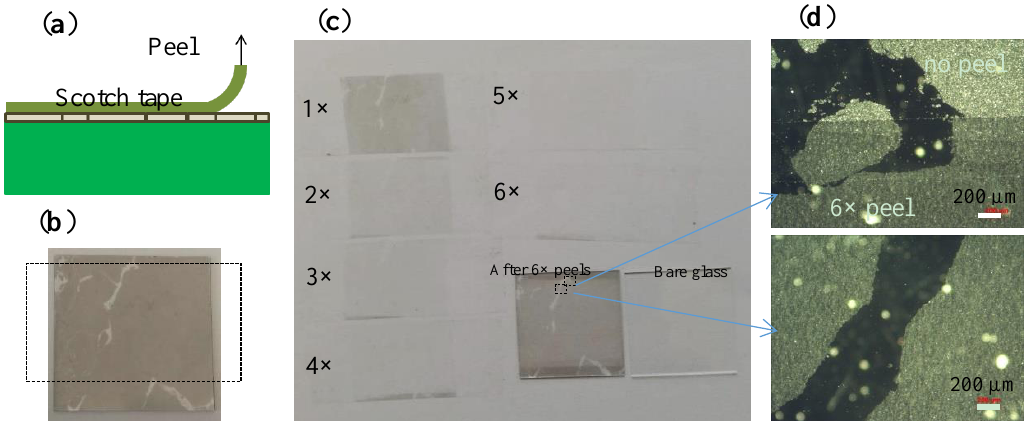
Figure 6. ( a ) Setup of the peel test; ( b ) The image shows a 2.5 × 2.5 cm 2 sample partially coated with MGFs before the peel tests; the dashed rectangle marks the position around which the peel tests were performed; ( c ) After each peel, the scotch tapes were stuck on a white paper one after another, and a bare Borofloat glass was included for comparison; ( d ) Micrographs at the positions marked with rectangles in ( c ).